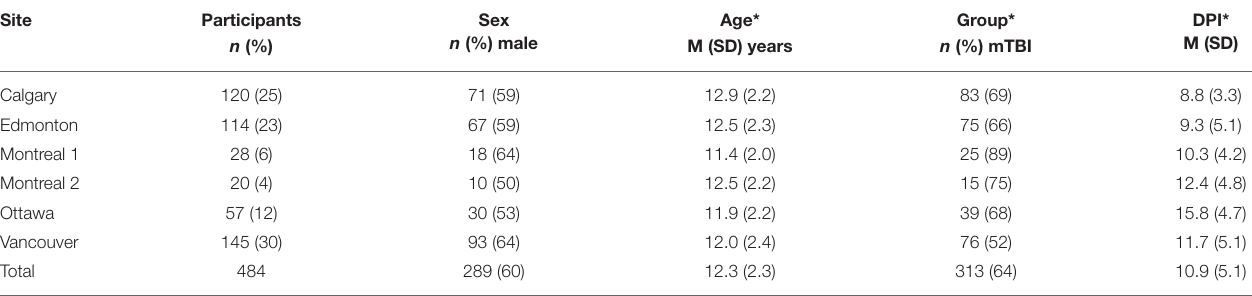
TABLE 1 | Demographic information for the participants at each site/scanner.